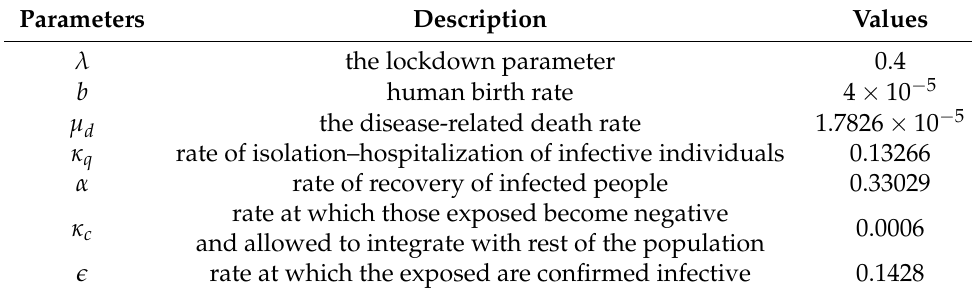
Table 1. Short description of model parameters and their values [7,8,30].